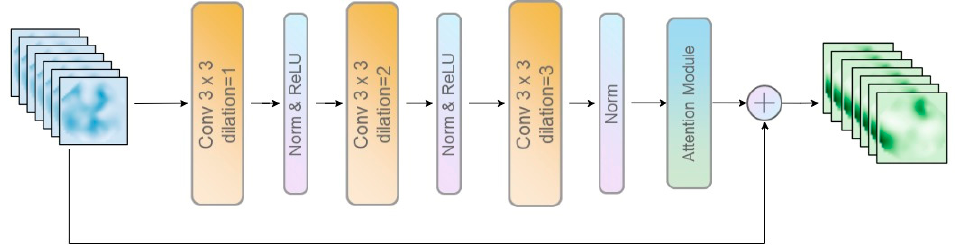
Figure 4. Different from general convolution, our MCA block is implemented based on three serial atrous convolution kernels (with dilation rates of r = 1, 2, and 3) and additionally includes a coordinate attention mechanism, thus increasing the capture range of the receptive fields.